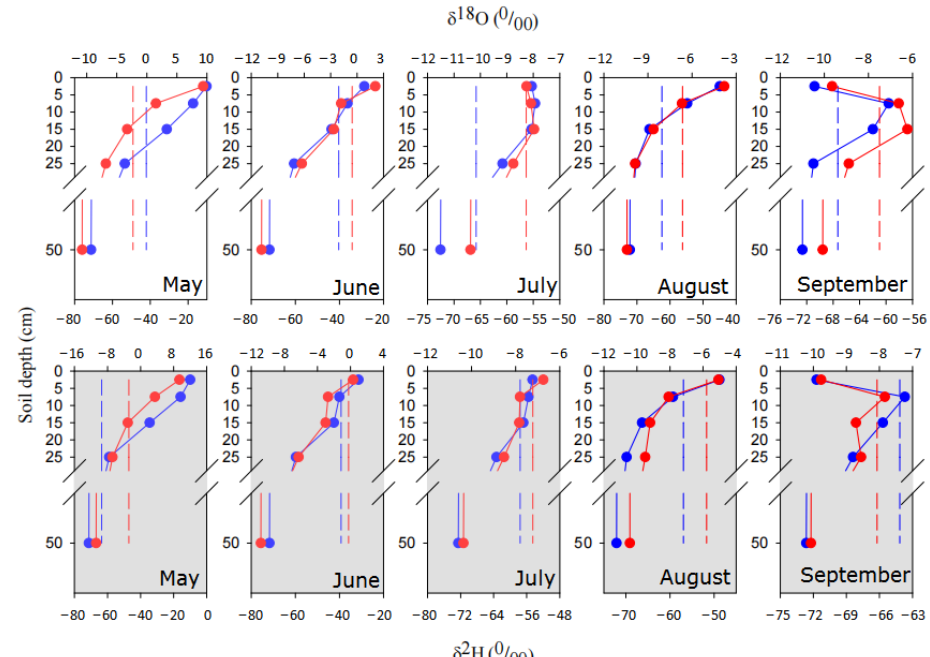
Figure A3. Intersection of δ 18 O and δ 2 H between soil water, groundwater and xylem water. δ 18 O and δ 2 H of soil water (0–30 cm), groundwater (50 cm) and xylem water in different months of Bromus inermis (white area) and Medicago sativa (gray area) grasslands. Red and blue symbols represent δ 18 O and δ 2 H, respectively. Red and blue dash lines denote δ 18 O and δ 2 H in xylem water, respectively.